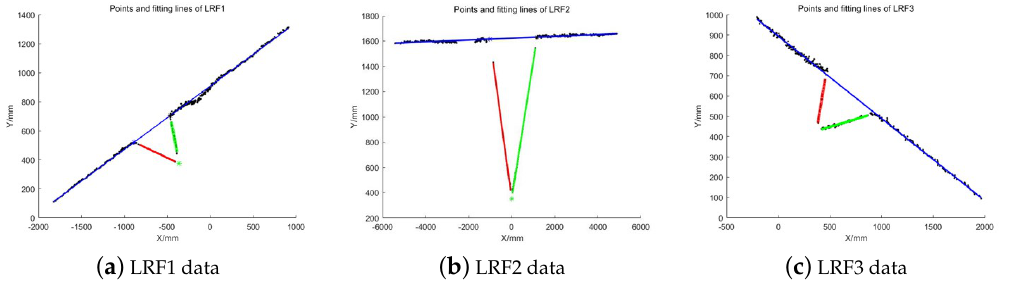
Figure 10. Results of WI fitting, the laser data, and fitting lines of ( a ) LRF1, ( b ) LRF2, and ( c ) LRF3, shown from left to